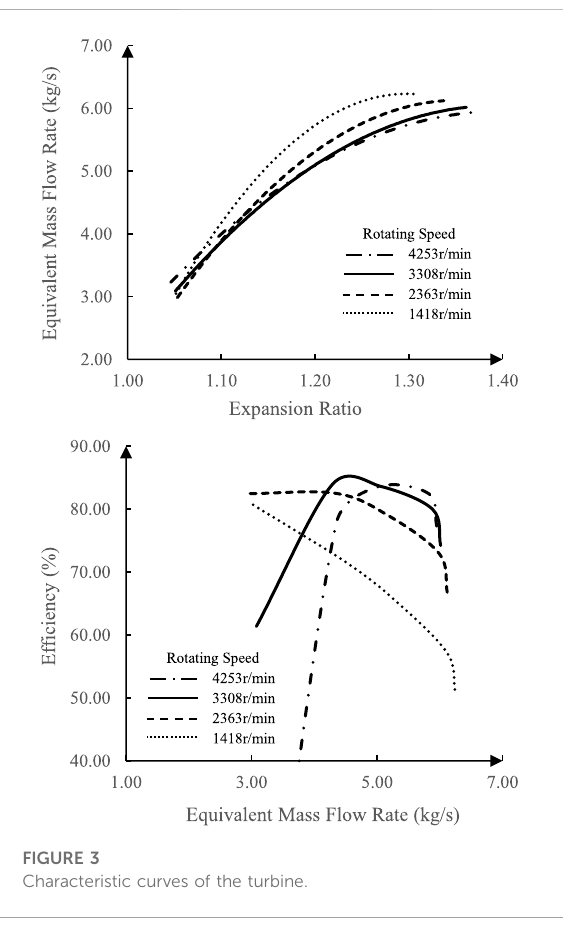
FIGURE 3 Characteristic curves of the